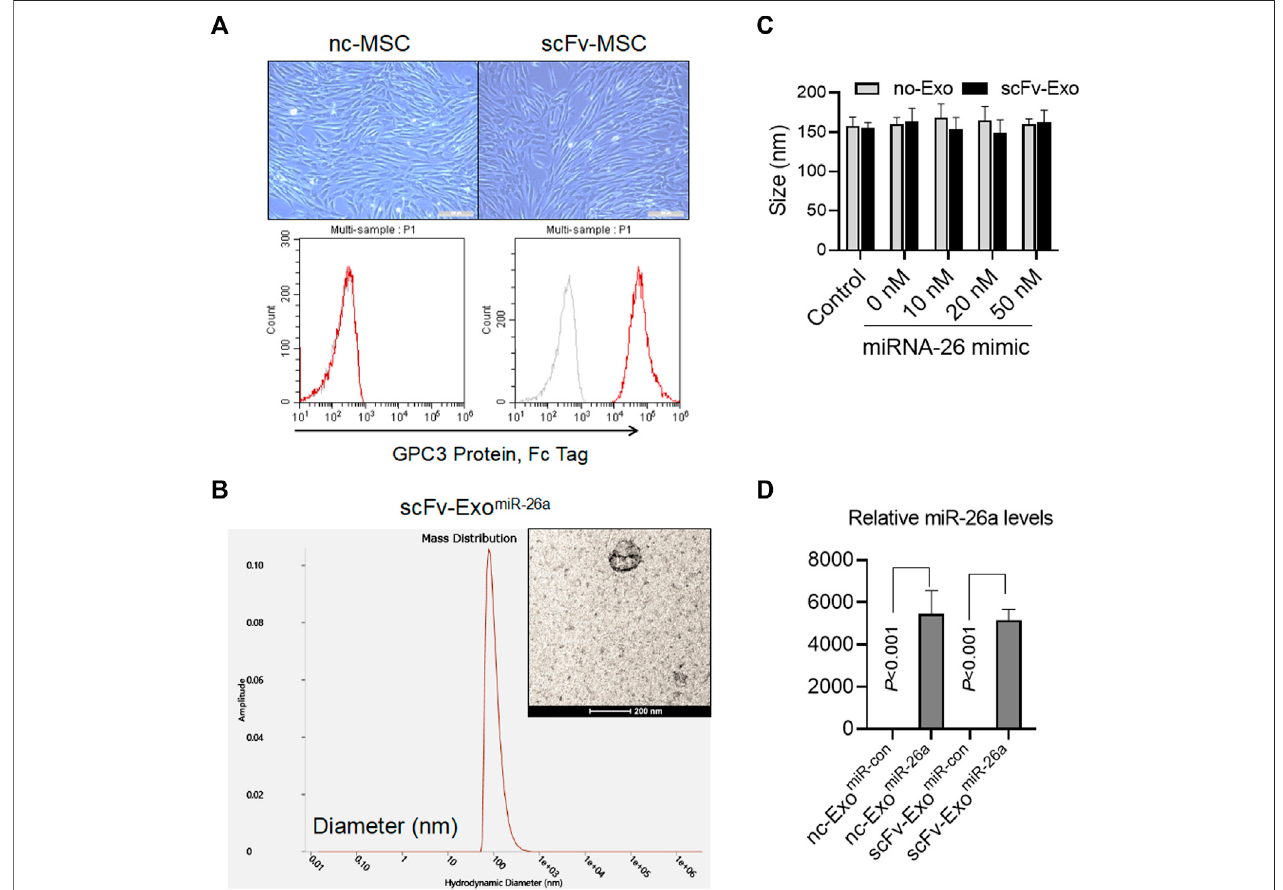
FIGURE 2 | Identi fi cation of exosomes loaded with miR-26a mimics. (A) Morphological characteristics of the fusion gene-modi fi ed MSCs were observed, and the expression of anti-GPC3 scFv on the surface of MSCs was detected by fl ow cytometry. Scale bars (cid:2) 50 μ m. (B) The morphology of exosomes loaded with 20 nM miR- 26a mimics (scFv-Exo miR-26a ) as determined by electron microscopy. The particlesize ofexosomeswasevaluated using dynamic light scattering. Scale bars (cid:2) 200 nm. (C) Different amounts of miR-26a mimics (0 – 50 nM) were electrotransferred into exosomes, and the particle size of exosomes was evaluated using dynamic light scattering. (D) Detection of miR-26 levels in engineered exosomes using quantitative real-time PCR